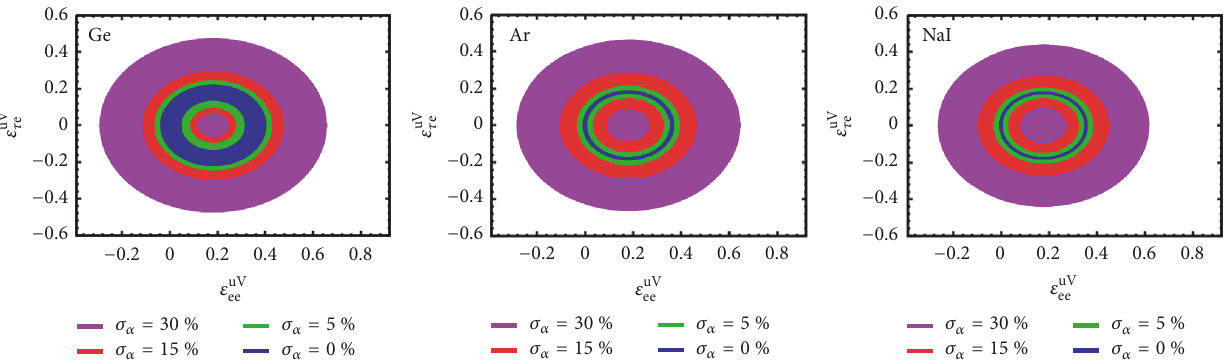
Figure 5: Expected sensitivity to 𝜀 𝑢𝑉 𝑒𝑒 vs. 𝜀 𝑢𝑉 𝑒𝜏 , at 90 % CL for the different detectors under consideration: Germanium, Argon, and NaI, respectively. As in previous cases, the different curves are for the ideal case of 𝜎 𝛼 = 0 % with 100 % efficiency and a background error of 𝜎 = 0 % (blue), for 𝜎 = 5 % with 50 % efficiency and a background error of 𝜎 𝛽 𝛼 background error of 𝜎 𝛽 = 10 % (red), and 𝜎 𝛼 = 30 % with 100 % efficiency and a background error of 𝜎 𝛽 = 10 % (magenta); see text for